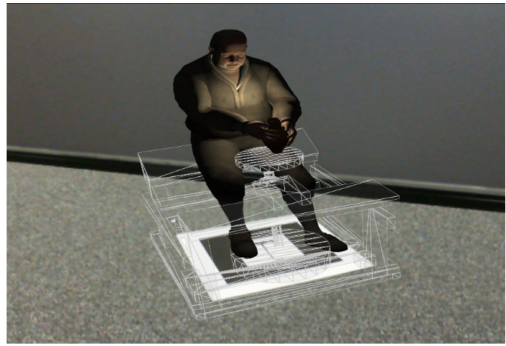
Figure 7. An animated avatar showing how to use a pottery wheel (laboratory setup).